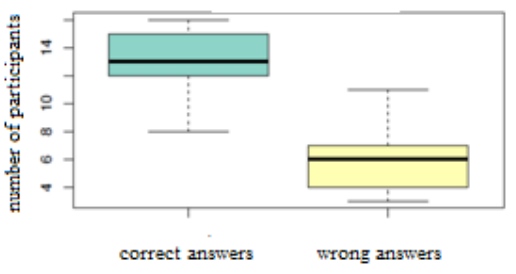
Figure 6 . Boxplot for adjunct sentences